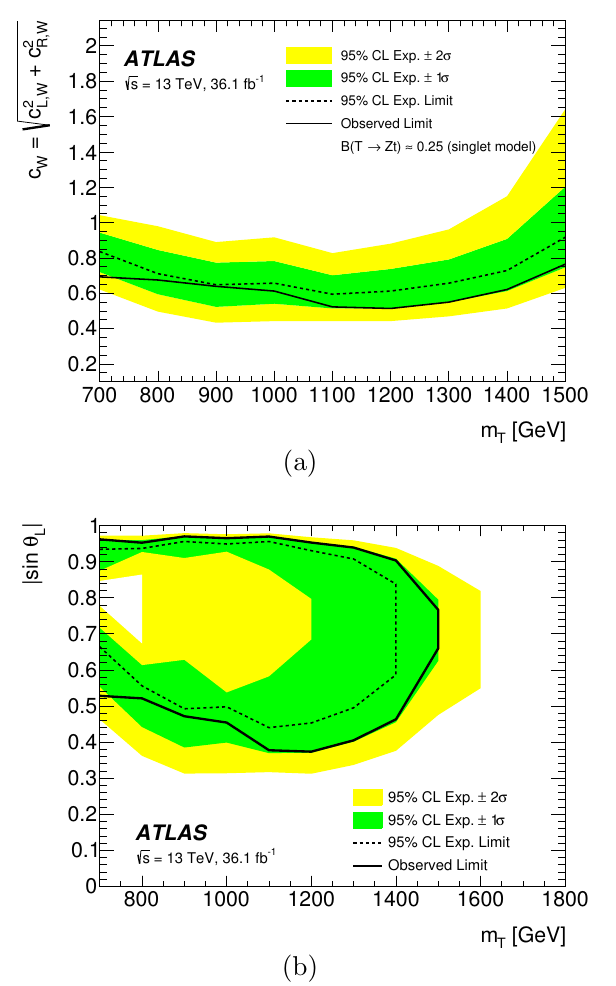
Figure 6 . Expected and observed 95% CL limits from the combination of the single-production channels on (a) the coupling of the T quark to SM particles, c W = singlet T , corresponding to a mixing angle of a singlet T with the SM